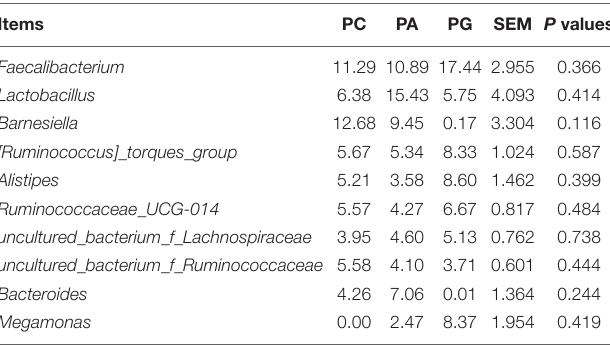
TABLE 12 | Effects of B. licheniformis and enramycin on relative abundances of genus in cecal microbiota of 25-day-old broilers challenged with SNE